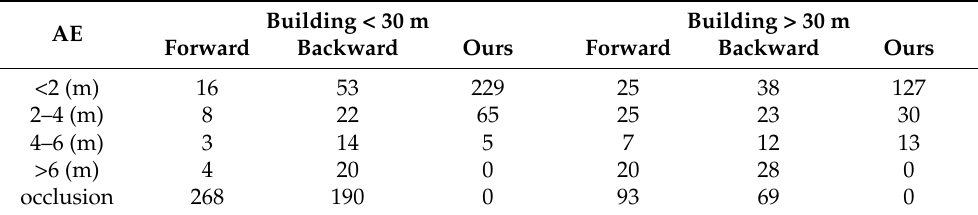
Table 5. The comparison of building number statistic at varying height